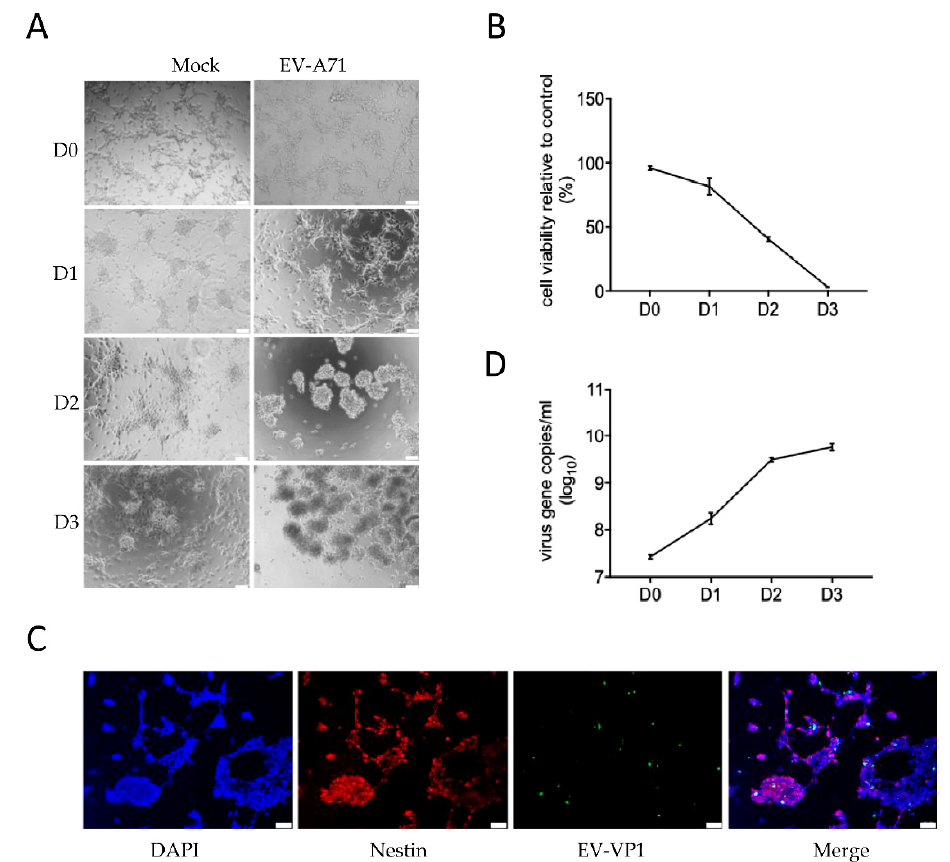
Figure 1. Human neural progenitor cells were susceptible to an Enterovirus A71 (EV-A71) infection. The differentiated human neural progenitor cells (hNPCs) in 24-well plates were infected with EV-A71 (multiplicity of infection (MOI) = 1.0). ( A ) Cytopathic effects were recorded under an inverted light microscope daily for three consecutive days. Mock-infected cells were used as negative controls. Scale bar: 50 μ m. ( B ) The hNPCs’ viability was determined by thiazolyl blue tetrazolium bromide (MTT) assay daily, from day 0 to day 3 post-EV-A71 infection using the condition as described above. ( C ) EV-VP1 viral protein expression (green) and neural stem cells (red) were detected at day 1 post-infection by fluorescence microscopy. Nuclear DNA was stained by 4 ′ ,6-diamidino-2-phenylindole (DAPI, blue). Scale bar: 50 μ m. ( D ) EV-A71 genomic copies in the cell culture supernatant were quantified by qRT-PCR at the different time points indicated. The experiments were carried out in triplicate and repeated twice for confirmation. Data are shown as means ± SEM.